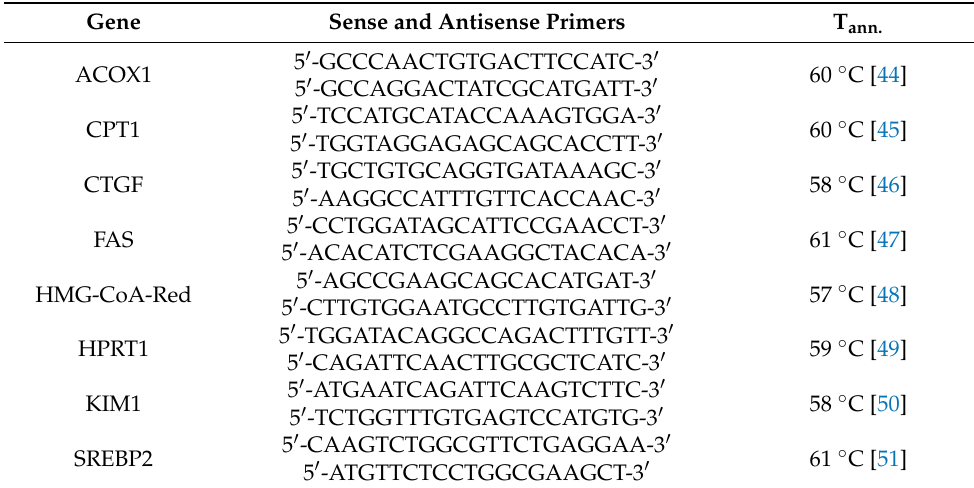
Table 1. List of primer pairs and annealing temperatures. Gene Sense and Antisense